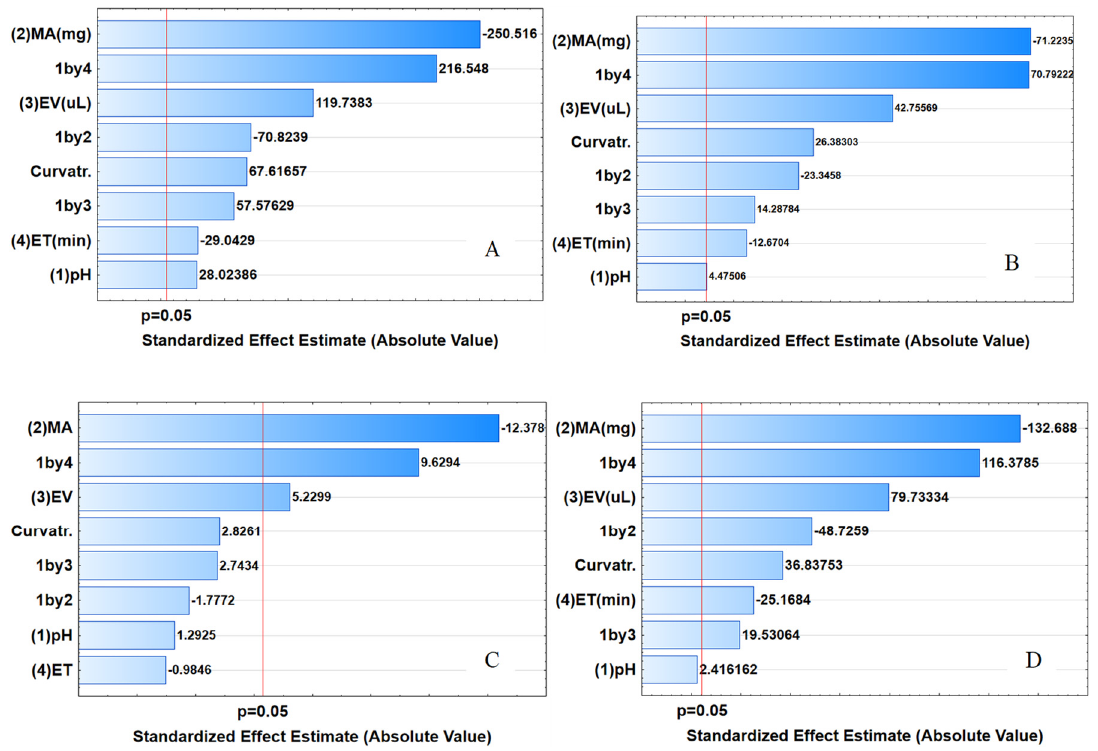
Figure 5. Pareto charts of standardized effects for variables in the preconcentration of steroid hormones ( A ) E1, ( B ) E2, ( C ) HYD and ( D ) PRO. (1) pH of working solution, (2) MA: mass of adsorbent, (3) EV: eluent volume, (4) ET: extraction time, 1by4: pH–ET interaction, 1by2: pH–MA interaction, 1by3: pH–EV interaction.